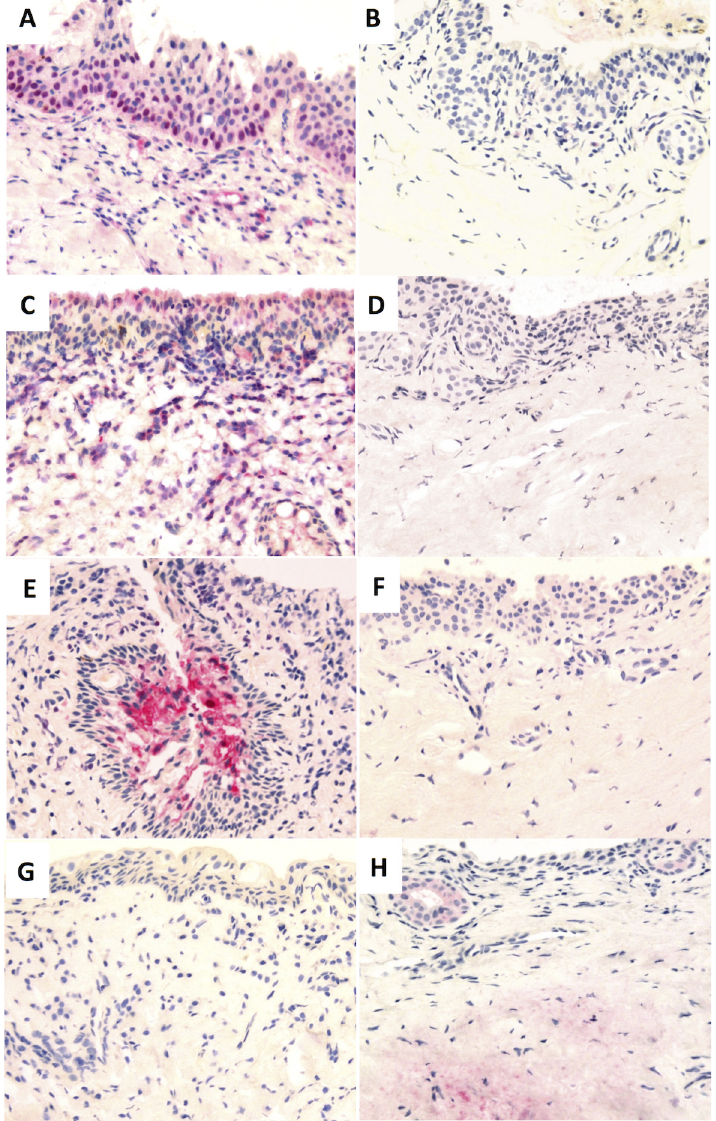
Fig 2. Example images of IHC staining. CTGF in the deep epithelium of TT cases (A) and controls (B), IL- 1 β in TT cases (C) and controls (D), S100A7 in a pseudogland of Henle of a TT case (E) and S100A7 staining in controls (F) and TGF β 2 staining in TT cases (G) and in controls (H). Images were taken at 200x original magnification.